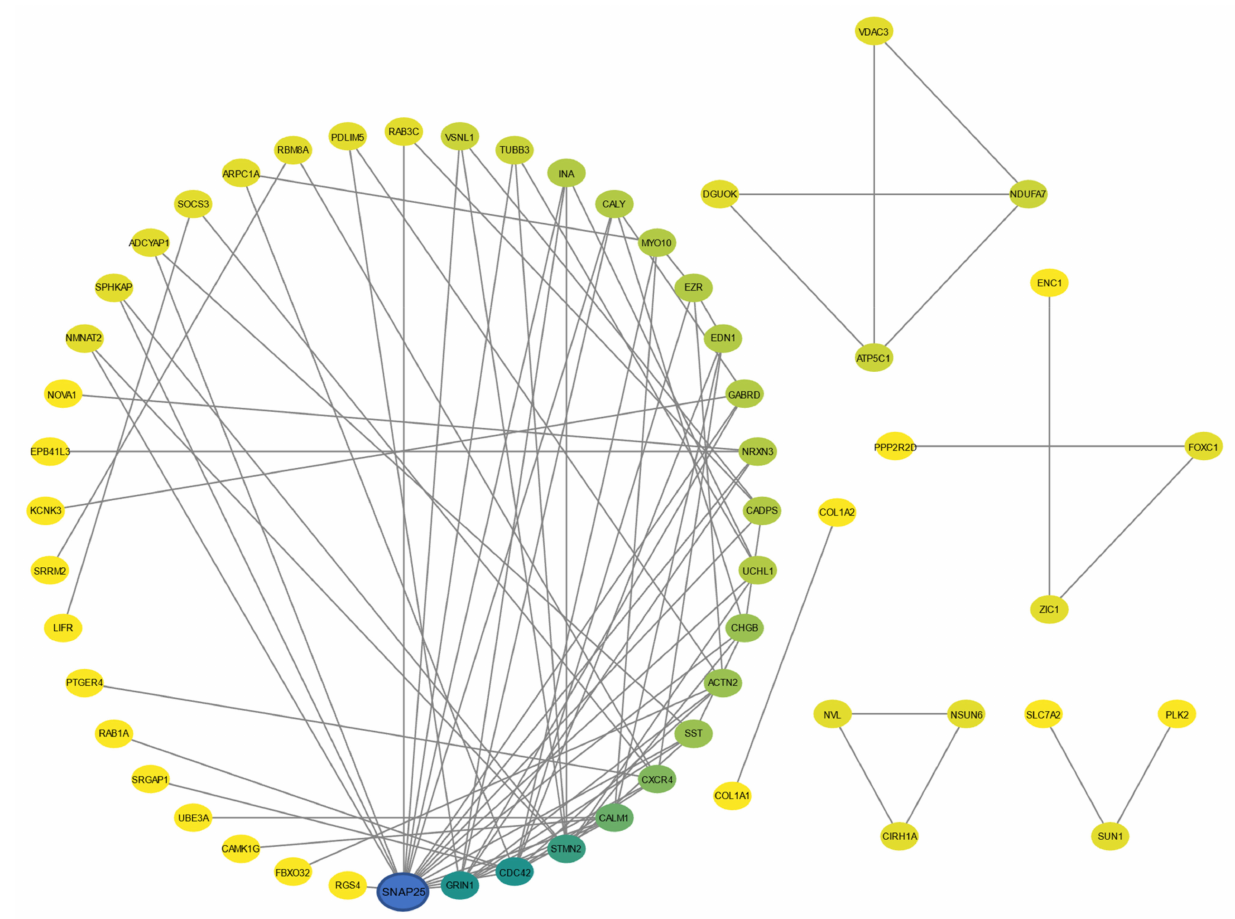
Figure 5. Protein–protein interaction (PPI) network from top 100 genes. Proteins are denoted as nodes and interactions as edges.